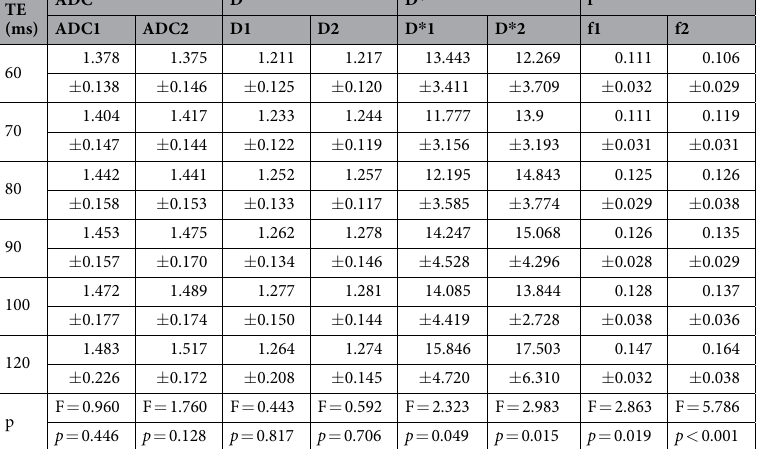
Table 5. Results of ADC, D, D * and f in the central zone with different TE value and ANOVA results. Note: Data are represented as the means ± standard deviations. ADC, D, D * are in units of 10 − 3 mm 2 /s; f has no units. ADC1, D1, D * 1 and f1 are the measurement results for the first examination; ADC2, D2, D * 2 and f2 are the measurement results for the second examination.